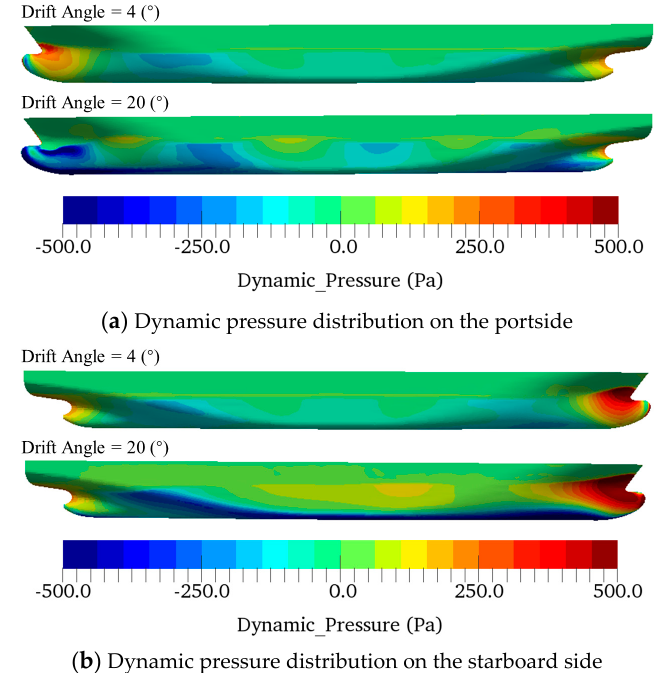
Figure 7. Dynamic pressure distribution on the hull: ( a ) dynamic pressure distribution on the portside; ( b ) dynamic pressure distribution on the starboard side.